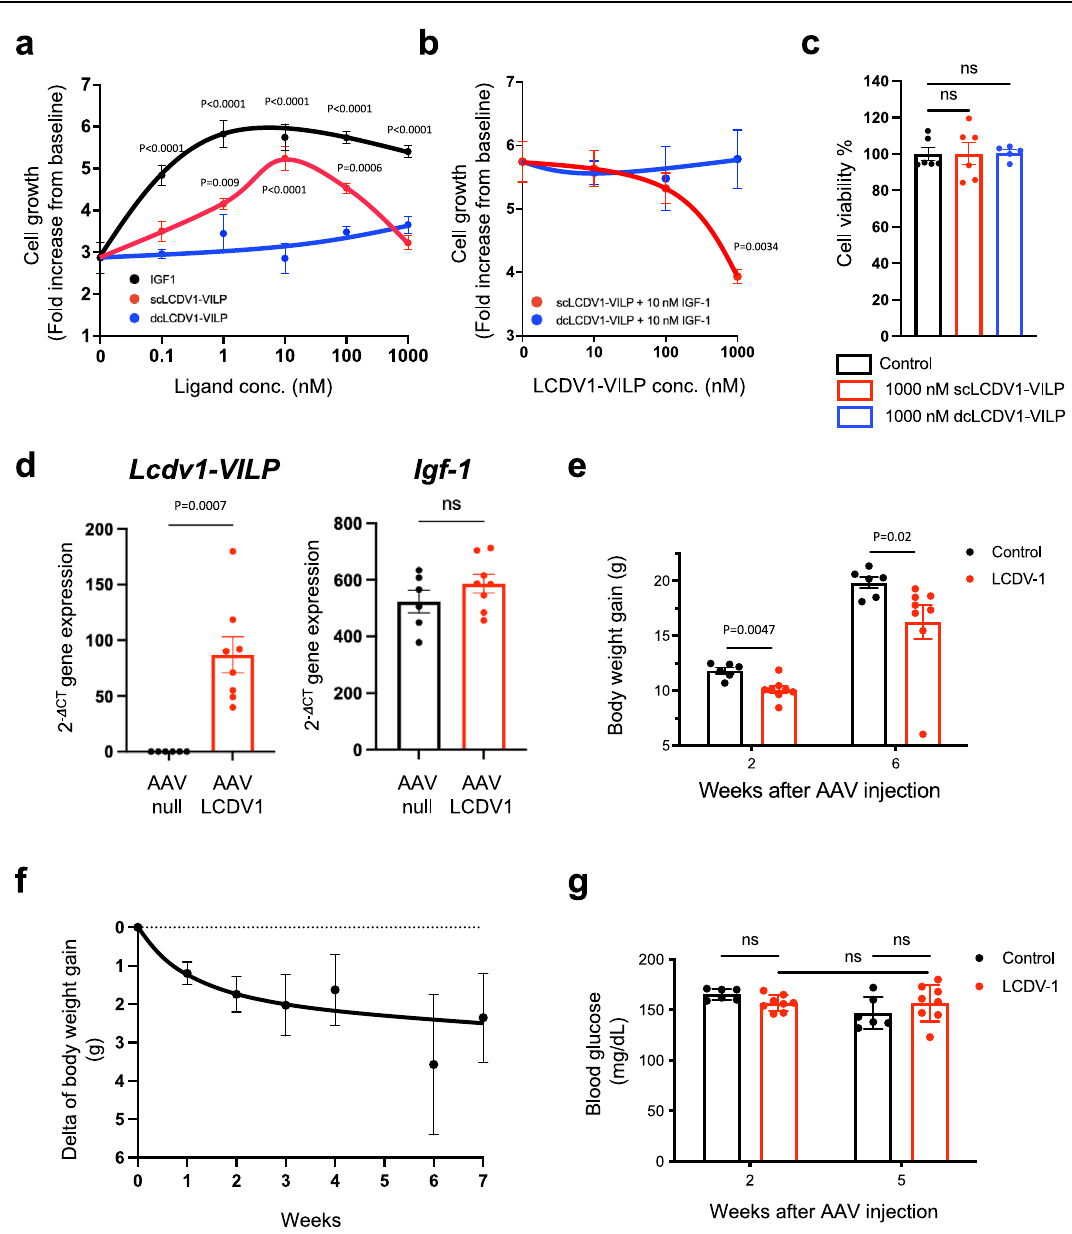
Fig. 4 | scLCDV1-VILP reduces cell proliferation and growth in mice over- secreting bovine growth hormone. a Murine preadipocytes overexpressing the humanIGF1Rwereplatedatadensityof20,000cells/wellthencountedaftera48-h incubationwith the indicatedconcentrationsof IGF-1,scLCDV1-VILPand dcLCDV1- VILP. Data are expressed as the mean±SEM (Two-way ANOVA followed by a Dun- nett ’ s multiple comparison test (Graphpad Prism V.9); n =3 independent experi- ments). b The number of murine preadipocytes expressing the hIGF1R were counted after a 48-h incubation with various concentrations of scLCDV1-VILP and dcLCDV1-VILPanda fi xedconcentrationofIGF-1(10nM).Dataareexpressedasthe mean±SEM (two-way ANOVA followed by a Š ídák ’ s multiple comparison test (Graphpad Prism V.9); n =3 independent experiments). c Viable murine pre- adipocytes overexpressing the hIGF1R were stained with crystal violet after a 48-h incubation with various concentrations of IGF-1, scLCDV1-VILP and dcLCDV1-VILP. Data areexpress as mean±SEM (ns, not signi fi cant;Kruskal-Wallistestfollowed by